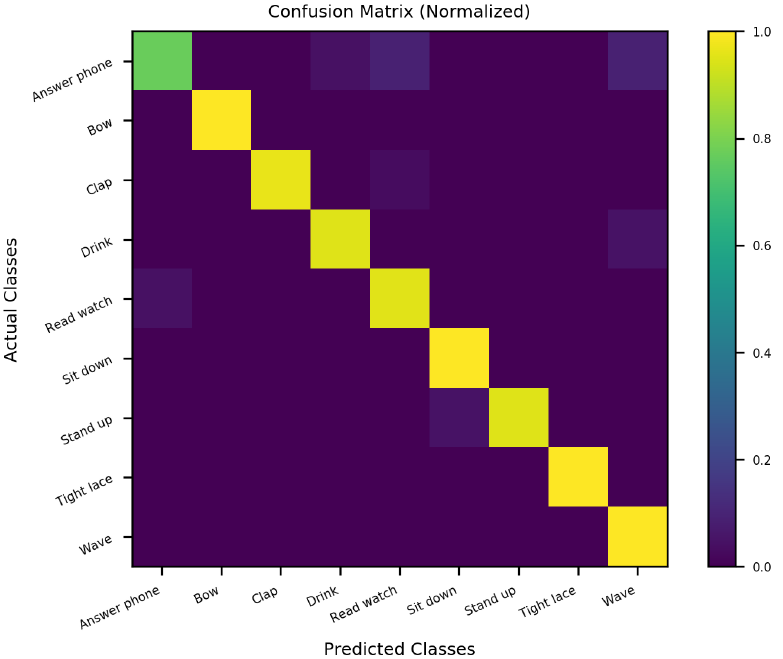
Figure 19. The normalized confusion matrix for SO-ConvESN-ASHA on Florence3D-Action